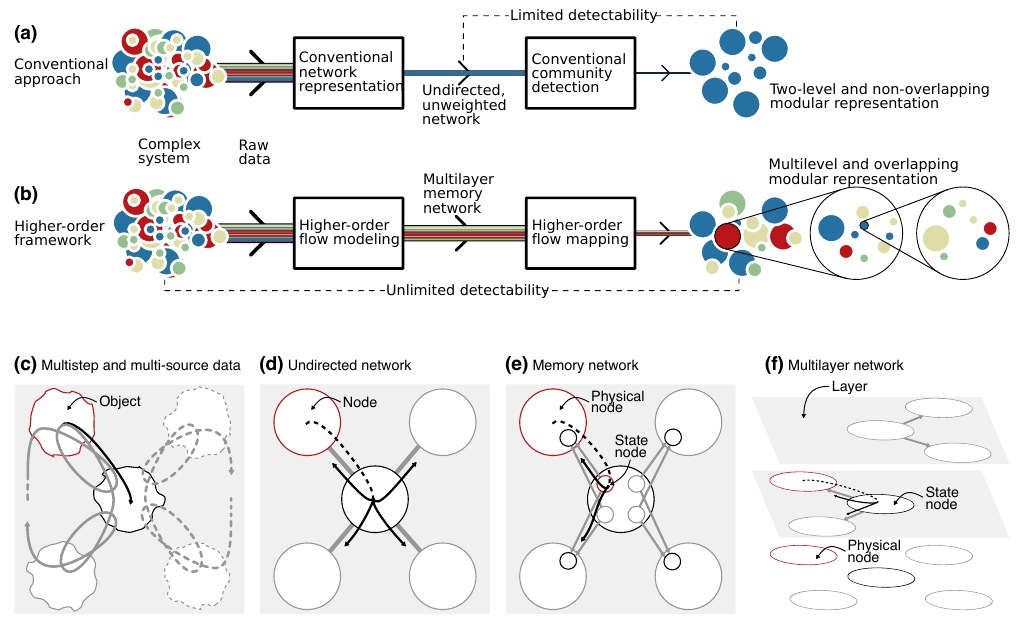
Figure 1. Going beyond standard network representations makes it possible to take advantage of richer interaction data. ( a ) Standard methods shoehorn interaction data about a complex system into an often unweighted and undirected network, which limits what regularities can be detected; ( b ) Modeling and mapping higher-order network flows can break this detectability limit; ( c ) System flows from two data sources between objects. The black arrow shows how flows can come to the center object; ( d ) The system represented as an undirected network with nodes for the objects. The links show where flows coming in to the center node are constrained to go next; ( e ) The system represented as a memory network with physical nodes for the objects and state nodes for constraining flows along their links. The links show where flows coming in to the center node are constrained to go next depending on where they come from; ( f ) The system represented as a multilayer network with physical nodes for the objects and state nodes in layers corresponding to different data sources. The links show where the flows coming in to the center node are constrained to go next depending on which layer they are